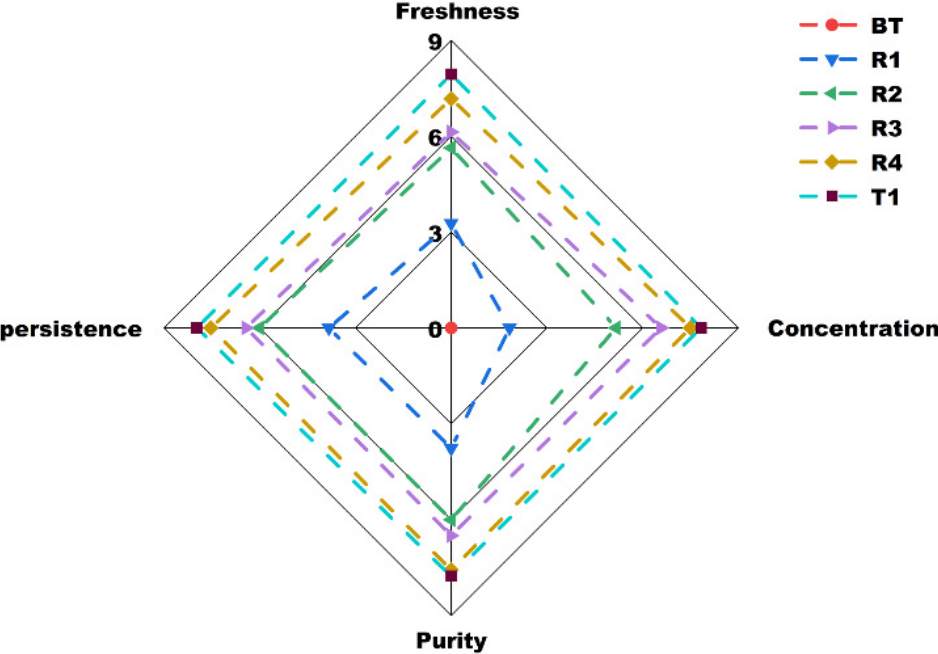
Figure 2. Spider plot of the aroma profiles of baked green tea (used as base tea) and jasmine tea with different rounds of scenting processes. BT: base tea; R1, R2, R3, R4: jasmine tea with one (R1), two (R2), three (R3), and four (R4) rounds of scenting processes; T1: jasmine tea with four rounds of scenting processes and Tihua process.